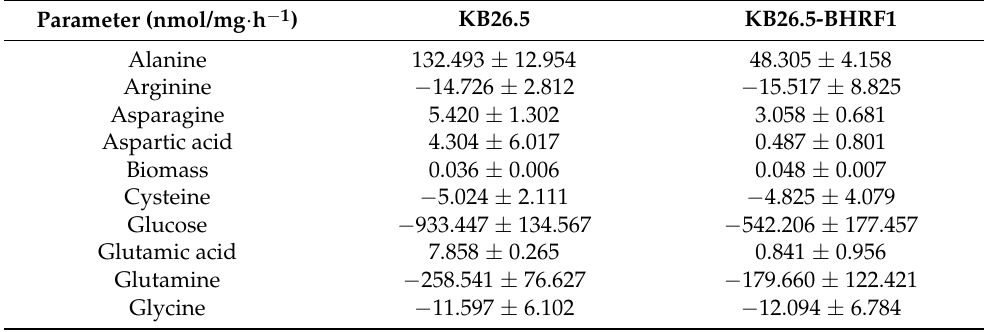
Table 1. Specific consumption rates of glucose, amino acids and oxygen, and production rates of lactate and ammonia for KB26.5 and KB26.5-BHRF1 cell lines. Cultures were run in 2 L bioreactors. The specific rates are part of the 38 external measured fluxes used as modeling constraints, and are expressed in nmol/(mg·h) units.